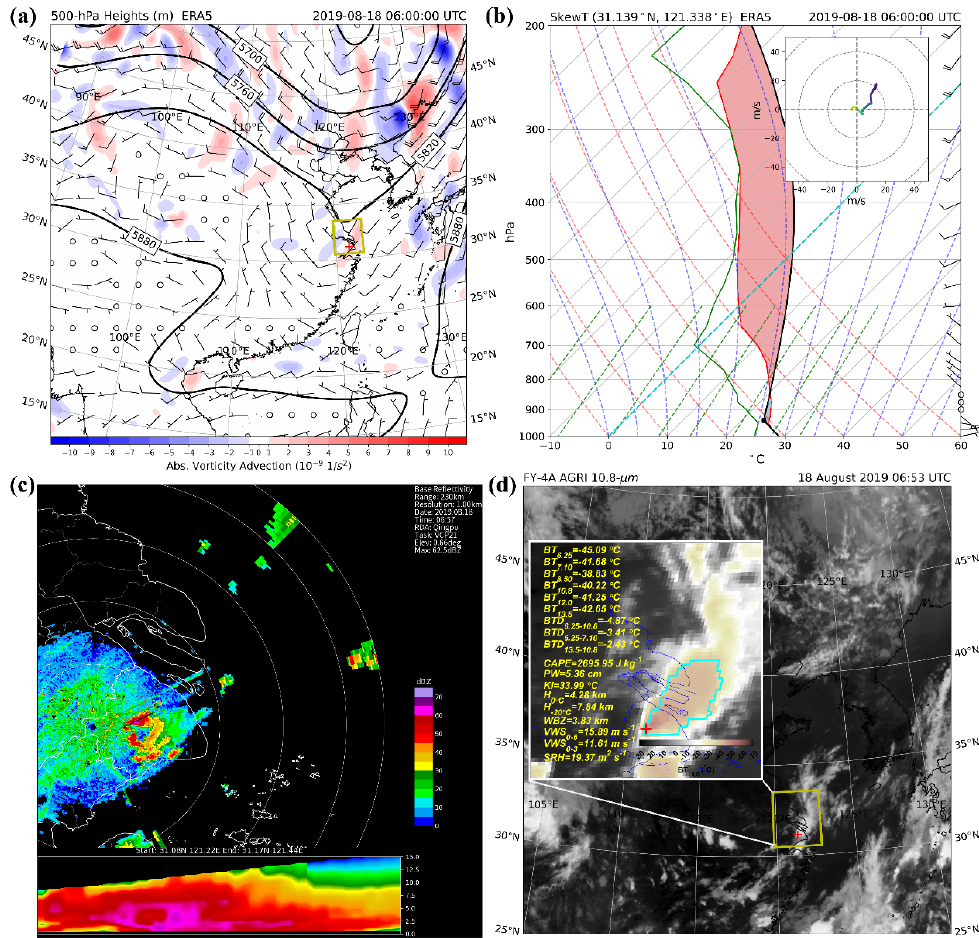
Figure 10. Hail event (red cross) occurred at about 06:57 (UTC) on 18 August 2019, in Songjiang District, Shanghai, China: ( a ) 500 hPa weather map; ( b ) SkewT near hail event; ( c ) radar reflectivity; ( d ) FY-4A 10.8 µ m image, the inset image shows the hailstorm sample (Figure 3a) that was to calculate MHD. The yellow rectangles in ( a , d ) represent the same geographic range.